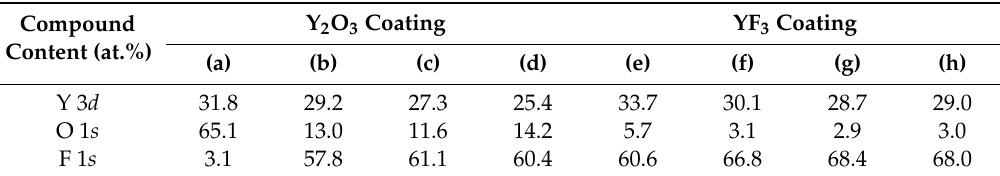
Figure 6. X-ray photoelectron spectroscopy (XPS) results: ( a ) Y 2 O 3 and ( e ) YF 3 before etching, ( b ) Y 2 O 3 and ( f ) YF 3 after etching of the powered electrode; ( c ) Y 2 O 3 and ( g ) YF 3 after etching of the grounded electrode; ( d ) Y 2 O 3 and ( h ) YF 3 after etching of the grounded wall.